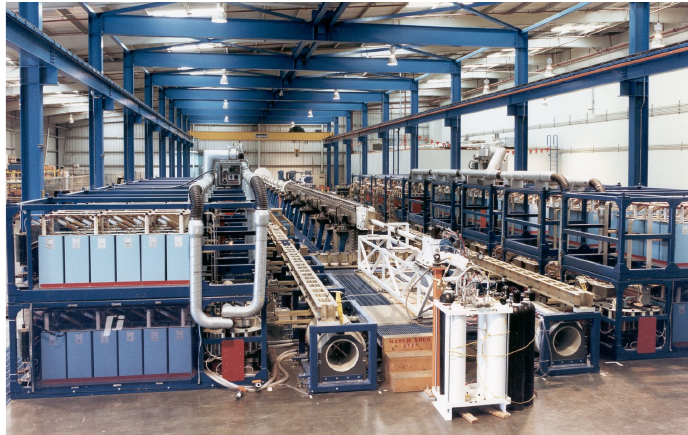
Figure 1. The capacitive PPS of 32 MJ of Green Farm in America.